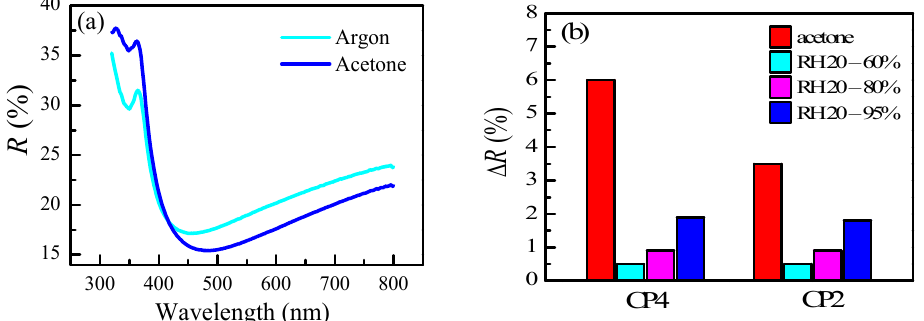
Figure 6. Reflectance spectra of CP4 copolymer thin films measured in ambient of argon and acetone vapors ( a ) and reflectance change ∆ R for CP2 and CP4 thin film samples due to acetone exposure (red bars) and due to relative humidity exposure in the ranges 20%–60% (cyan bars), 20%–80% (magenta bars), and 20%–95% (blue bars) ( b ).